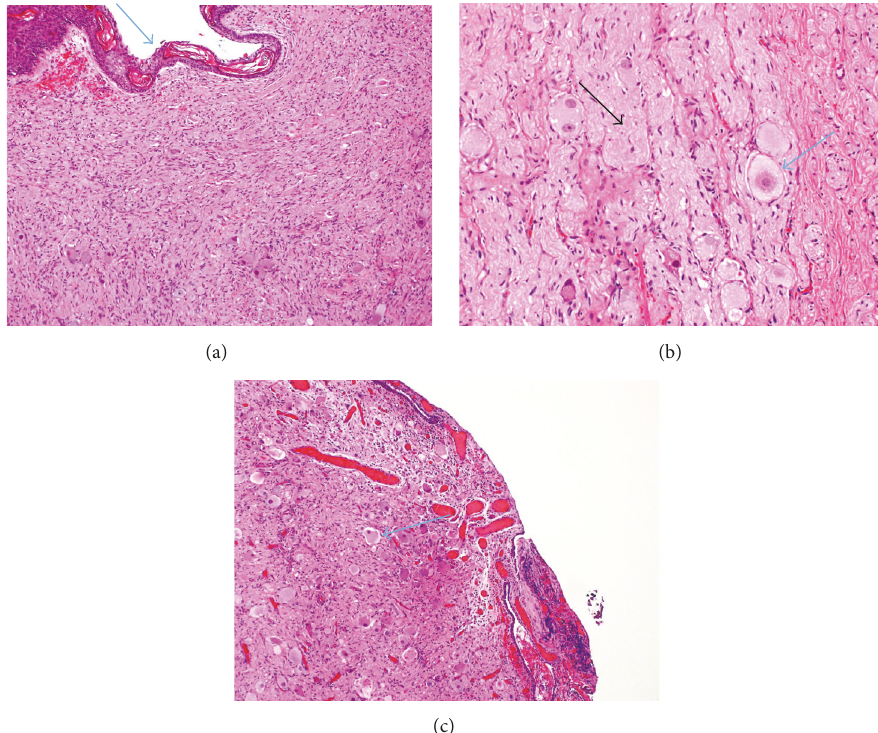
Figure 5: Hematoxylin and eosin stain (H&E stain). (a) Ear canal ganglioneuroma (10x). Showing (arrow) surface squamous epithelium of the external auditory canal and the ganglioneuroma beneath the surface. (b) High power (40x) showing ganglion cells (blue arrow) without rim of satellite cells among Schwannian stroma (black arrow). (c) (10x) Epitympanum showing ganglion cells (arrow).